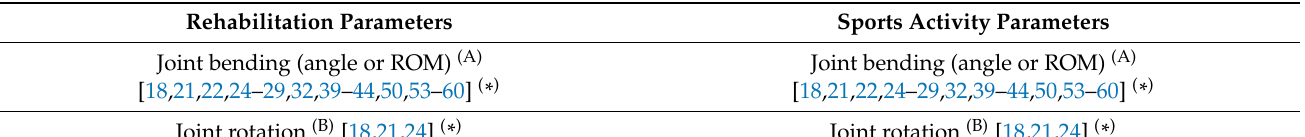
Table 2. Classification of human physiological parameters usually identified in monitoring